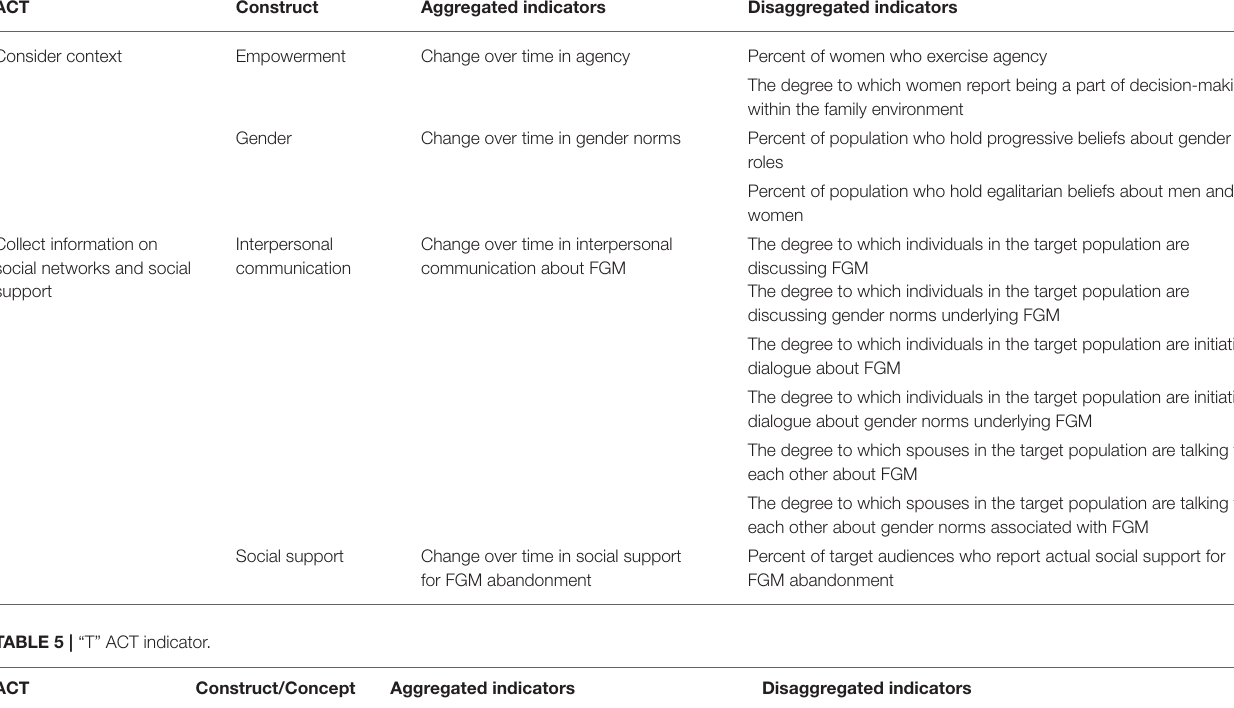
TABLE 4 | “C” ACT indicators.